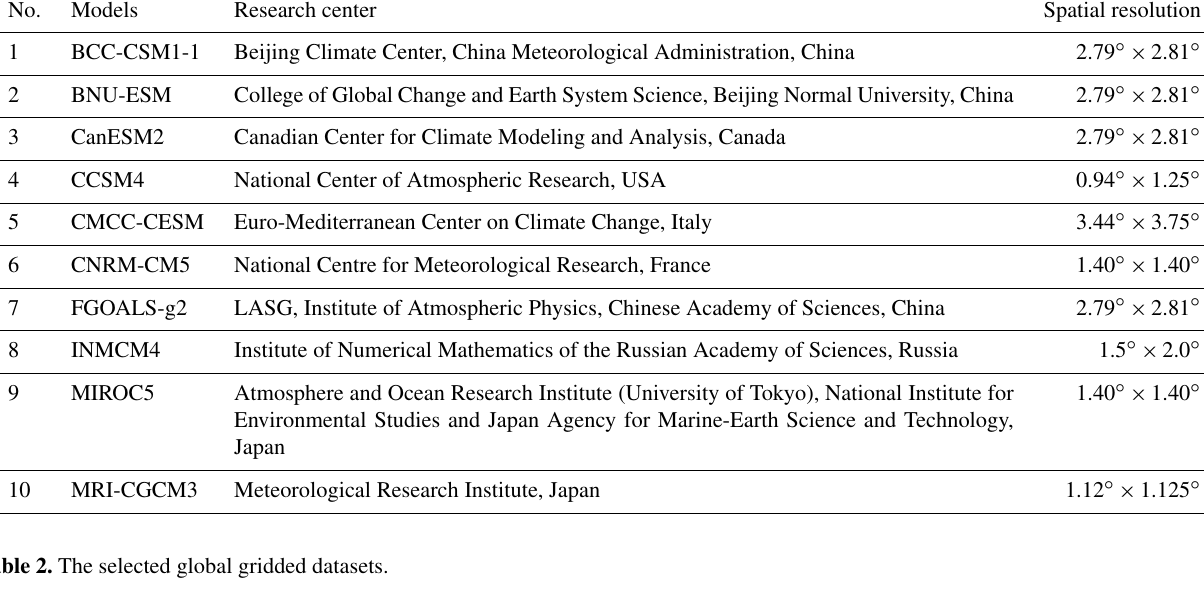
Table 1. List of chosen GCMs, research centers and spatial resolutions. No. Models